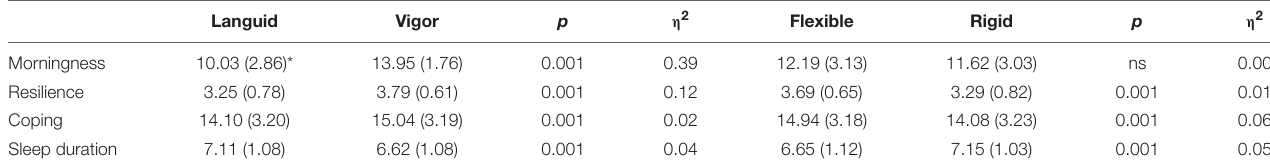
FIGURE 1 | Distribution of languid-vigor and flexible-rigid types by age categories. TABLE 2 | Mean scores and effect size for languid-vigor ( n = 456) and Flexible-Rigid ( n = 456) types by dependent variables. Languid